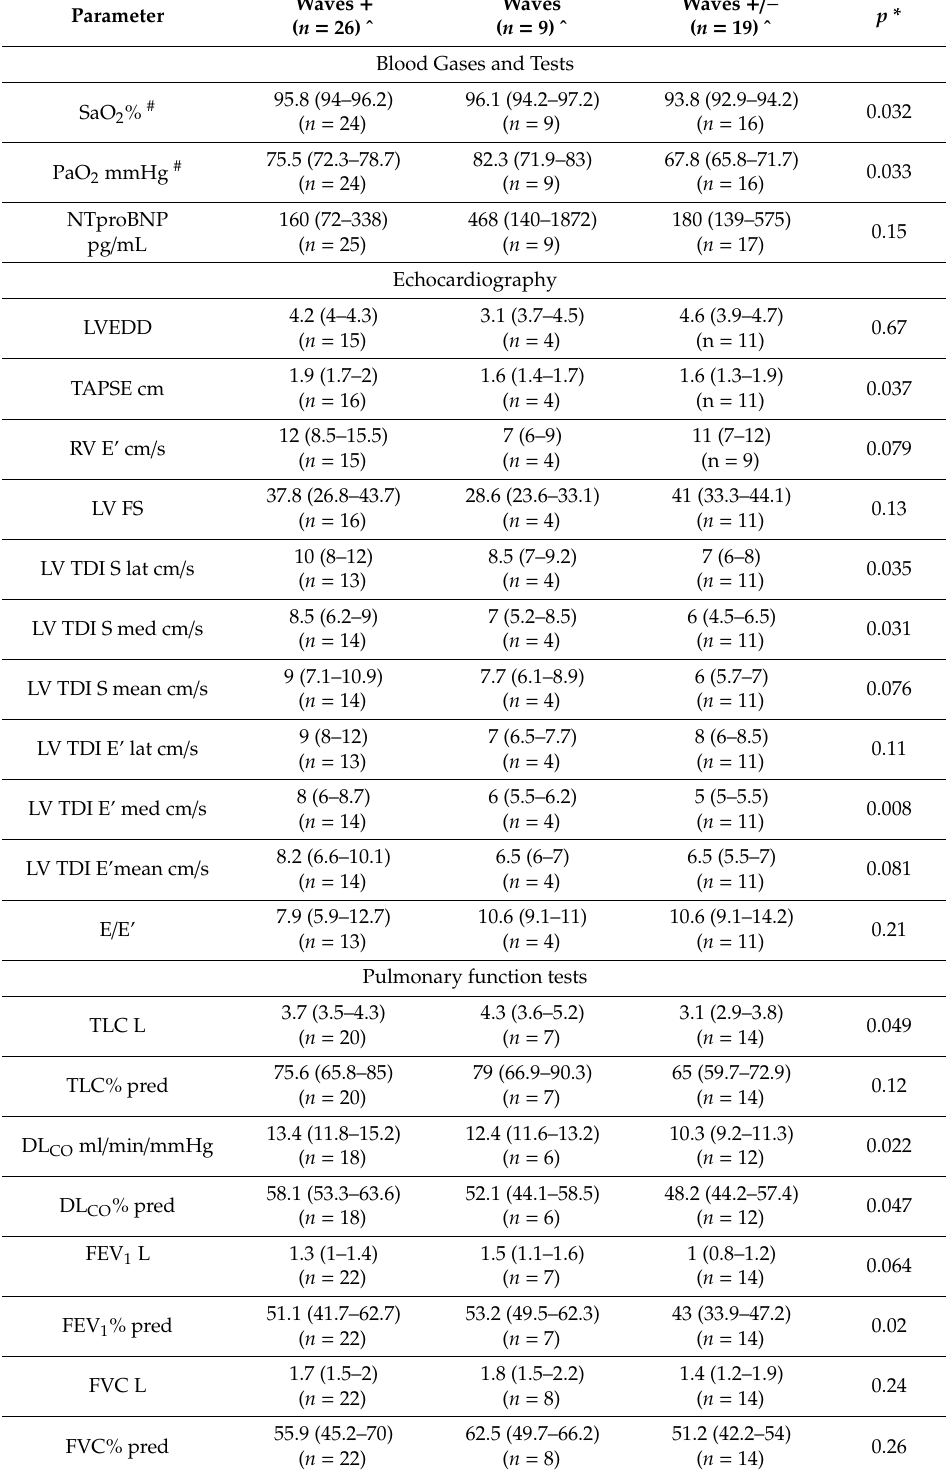
Table 2. Vital signs, selected echocardiographic, and pulmonary function parameters in 3 subgroups with di ff erent degrees of pleural pressure pulse